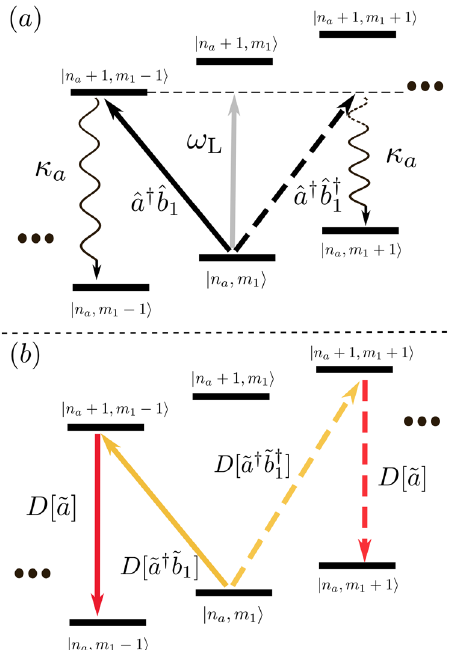
Fig. 2 Cooling mechanism. The underlying energy transitions between the (cid:3) (cid:4) (cid:3) dressed states n a ; m 1 of the optomechanical system with a single mechanical resonator. In both panels, solid and dashed lines show the cooling and heating process, respectively. a The cooling and heating processes in the presence of coherent laser drive of frequency ω L . The cooling process proceeds by the absorption on the lower sideband, leading to the leakage of a blue-shifted photon from the cavity by destroying one phonon. On contrary, absorption at the upper sideband leads to the heating of the mechanical resonator 11 . b The energy transitions involved in the cooling and heating process in our proposed scheme. As opposed to laser cooling, the transition at the lower sideband ( ω − ) is induced by the hot bath via the incoherent y (cid:3) in Eq. (36). This creates an energetic system – bath interaction, given by D ½ ~ a ~ b 1 (blue-shifted) photon which is dumped in a bath at lower temperature T c . Cooling with a single optical bath is not allowed by the second law of (cid:3) (cid:3) thermodynamics. Because, in the case of a single optical bath, n a ; m 1 mechanical to optical bath for T 1 < T h , hence we need another bath to be consistent with the second law of thermodynamics. In the heating process, the hot bath induces the transition of frequency ω + following by the dumping of a photon in the cold bath, which results in heating of the mechanical resonator. For the cooling process to dominate, the upper sideband frequency ω fi ltered from the system – bath coupling spectra, as shown in Fig. + is